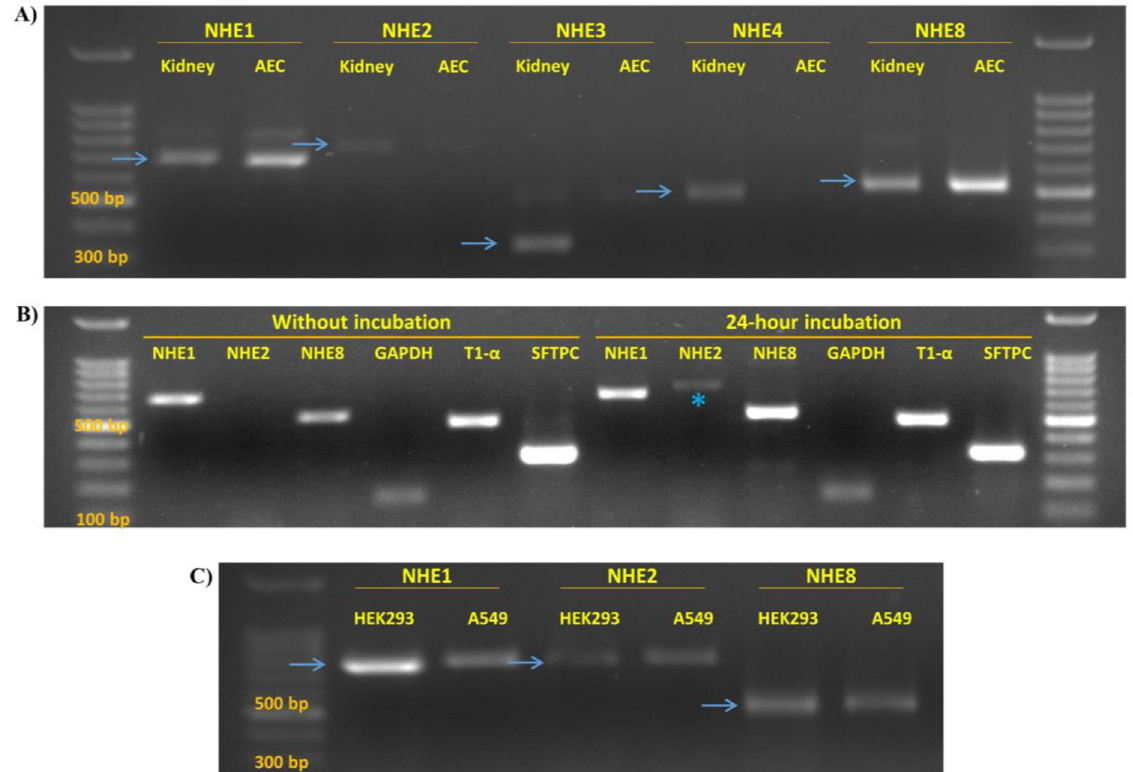
Fig 1. (A) RT-PCR showing the expression of NHE isoforms in isolated AEC as compared to kidney sample. Positive signals of NHE1 and NHE8, but not NHE2 and NHE3, were detected in AEC. (B) RT-PCR that illustrates NHE isoforms expression in AEC that were/or not 24-hour incubated. The asterisk indicate NHE2 expressed in AEC following incubation, but was absent when AEC were freshly assessed. (C) RT-PCR demonstrating the expression of NHE1, NHE2 and NHE8 in A549 and Human embryonic kidney 293 cell line (HEK293) that served as positive control. The blue arrows point to the expected product length. AEC—alveolar epithelial cells. NHE—Na + /H + Exchanger. GAPDH —Glyceraldehyde 3- phosphate dehydrogenase. T1- α –AECI marker, SFTPC—Surfactant Protein C, AECII